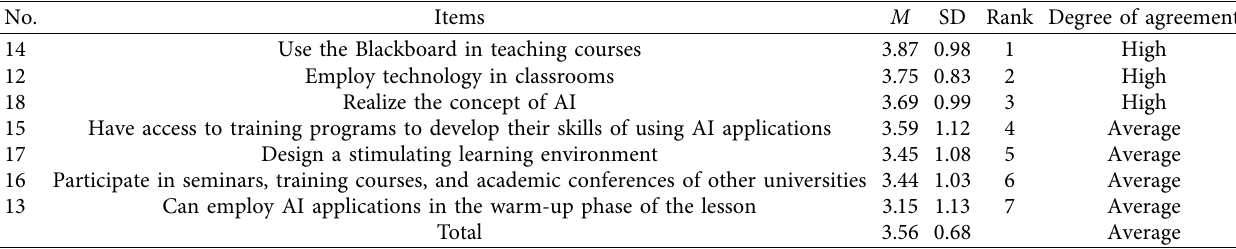
Table 6: Descriptives of the “faculty members” subdimension in descending order.